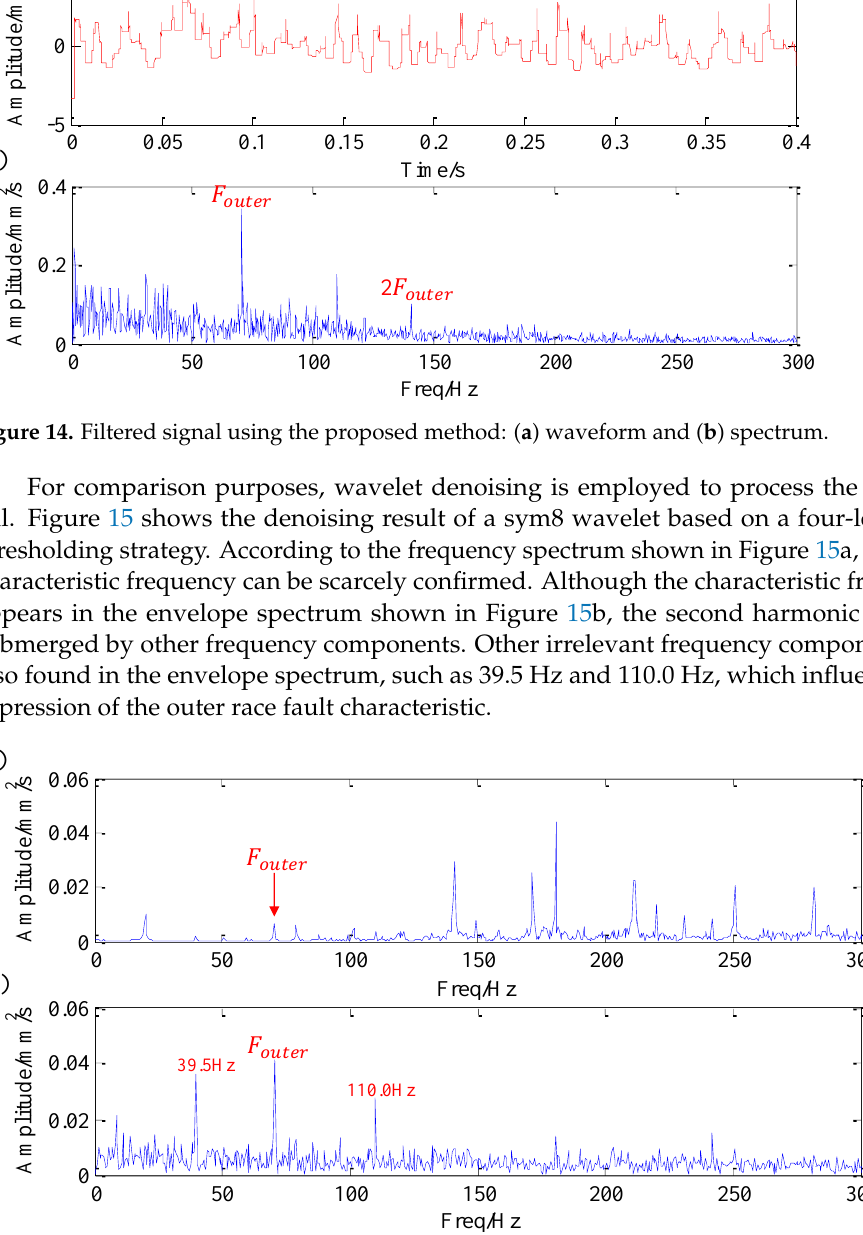
10 of 17 Figure 13. Fault bearing vibration signal: ( a ) waveform and ( b ) spectrum and ( c ) envelope spec- trum. 3.1.2. Fault Detection and Result Comparison In Figure 13c, the fault characteristic frequency 71.44 Hz cannot be identified clearly from the envelope spectrum because of heavy noise and interference. In order to inhibit noise and enhance fault features, the proposed method is applied for the bearing vibration signal. Since the raw signal contains 24,800 sampling points, the largest length of the struc- turing element is set to 248 points, and the search range is set to {2,3, … , 248} for the fol-